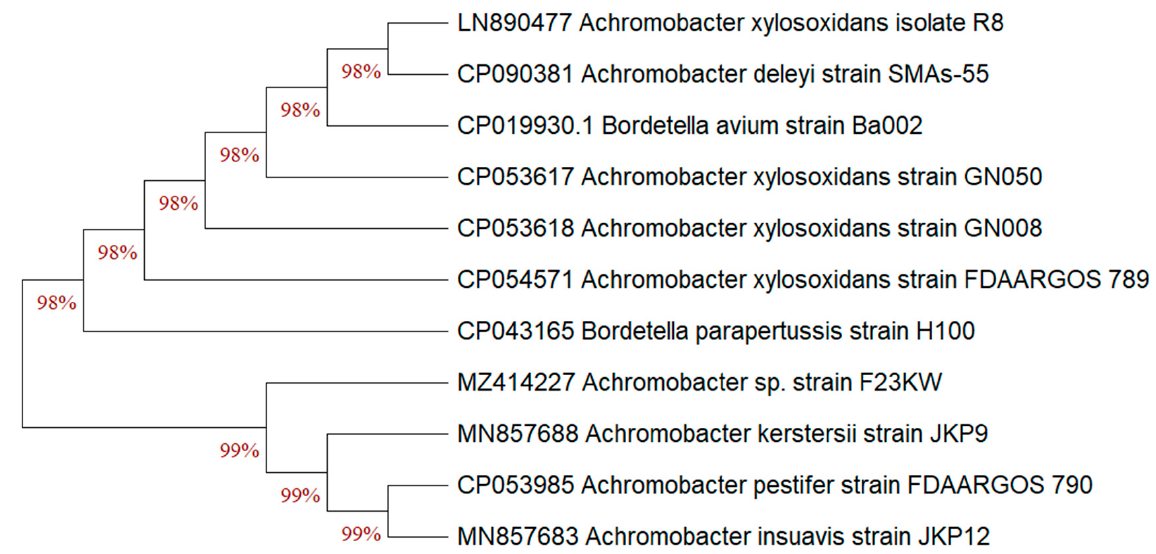
Figure 4. The neighbor-joining algorithm phylogenetic tree of Achromobacter sp. strain F23KW with respect to the closely related species of the genus on the Gene bank.